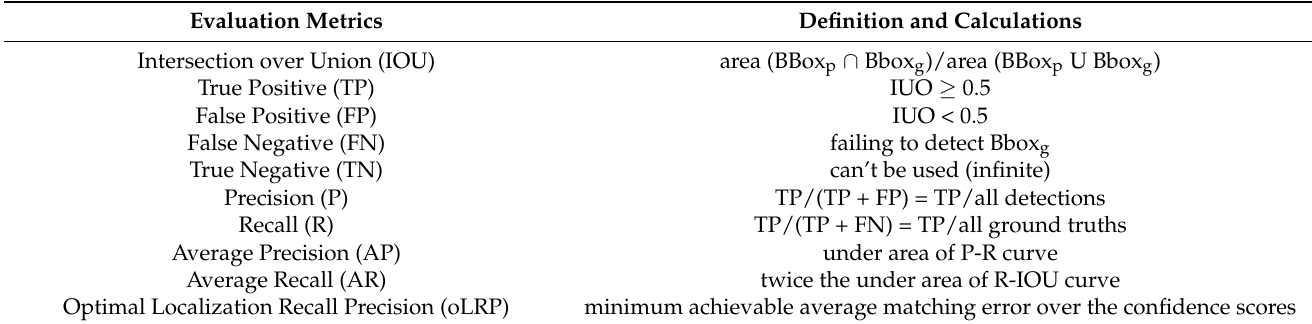
Table 4. Evaluation metrics definition and calculations.